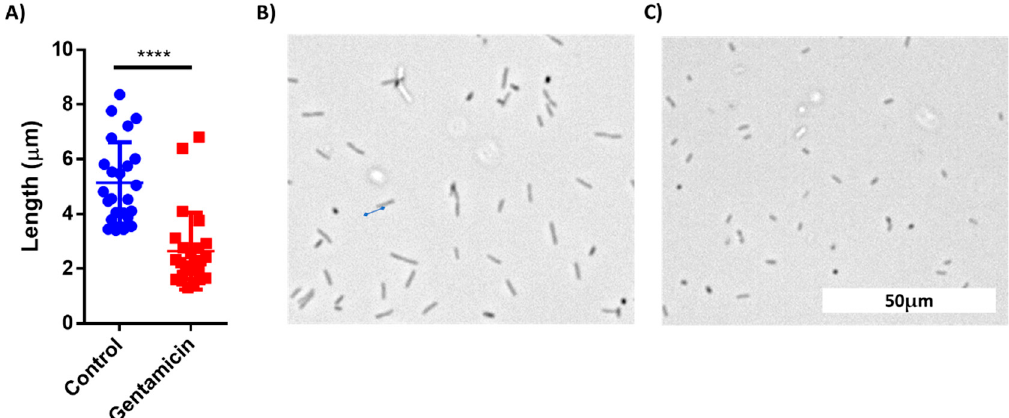
Figure 8. Comparison of cell length of treated and untreated E. coli cells after 60 min of incubation. ( A ) Cell length distribution between the control group and gentamicin-treated group. ( B ) A Brightfield microscopy photo of control cells. ( C ) A photo of gentamicin-treated cells. n = 25. Error bars indicate standard deviation (SD). **** P < 0.001.